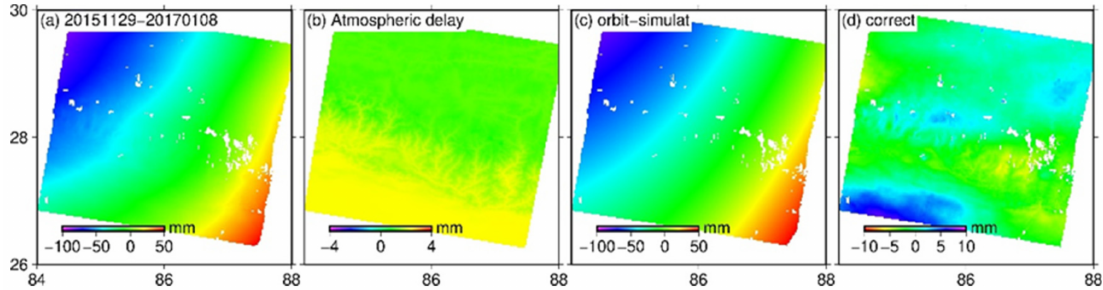
Figure 3. Correction effect of atmospheric delay and orbit phases of ALOS-2 interferogram; ( a ) Orig- inal interferogram; ( b ) the GACOS atmospheric delay phase; ( c ) simulated orbit phase; ( d ) the deformation field after removing the atmospheric delay phase and orbit